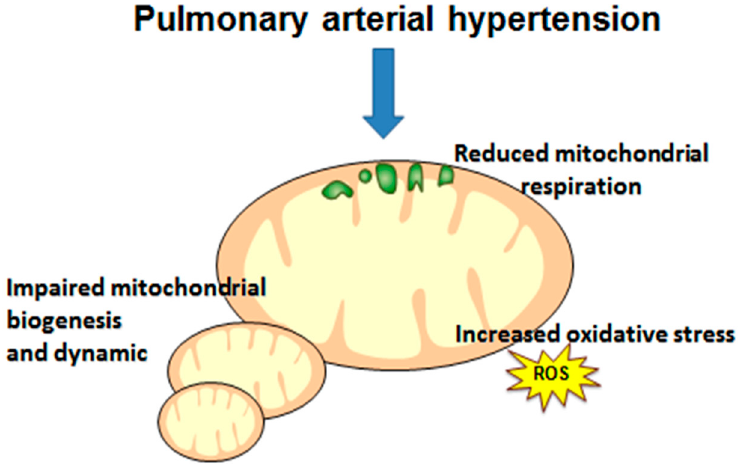
Figure 3. Mechanisms likely participating in pulmonary arterial hypertension-related mitochondrial dysfunctions in muscles.